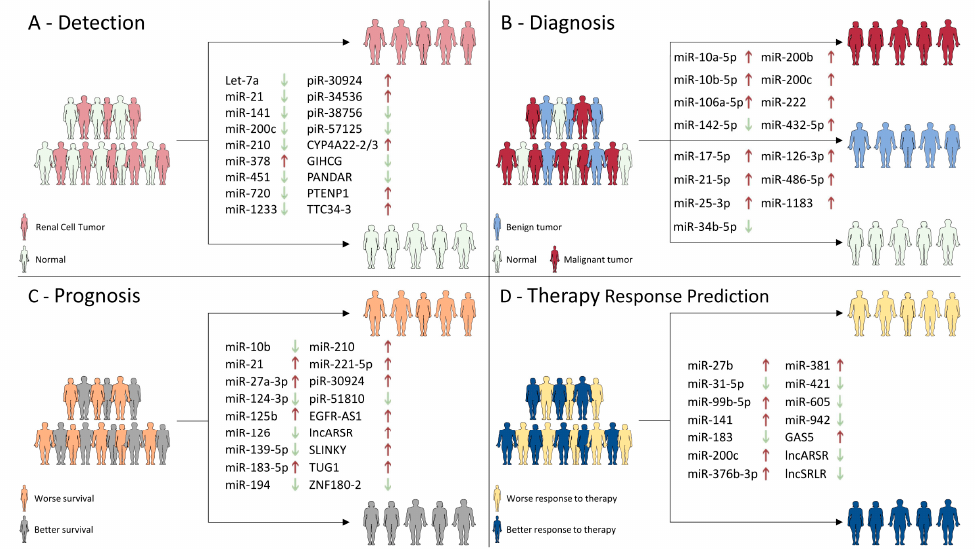
Figure 2. Summary of the most promising biomarker candidates for RCT. ( A ) Several ncRNAs have been proposed as ancillary tools for distinguishing tumor growth from normal tissue. Arrows represent each ncRNA expression level in RCT, comparing to normal samples (“red”—upregulated; “green”—downregulated). ( B ) Besides the potential use of ncRNAs to detect tumorigenesis, some were